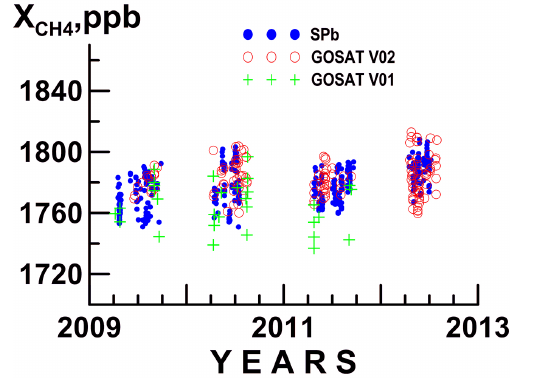
Fig. 1. Column-average methane mole fractions measured near Saint Petersburg with FTIR (SPb) and GOSAT (data versions V01.xx and V02.xx).